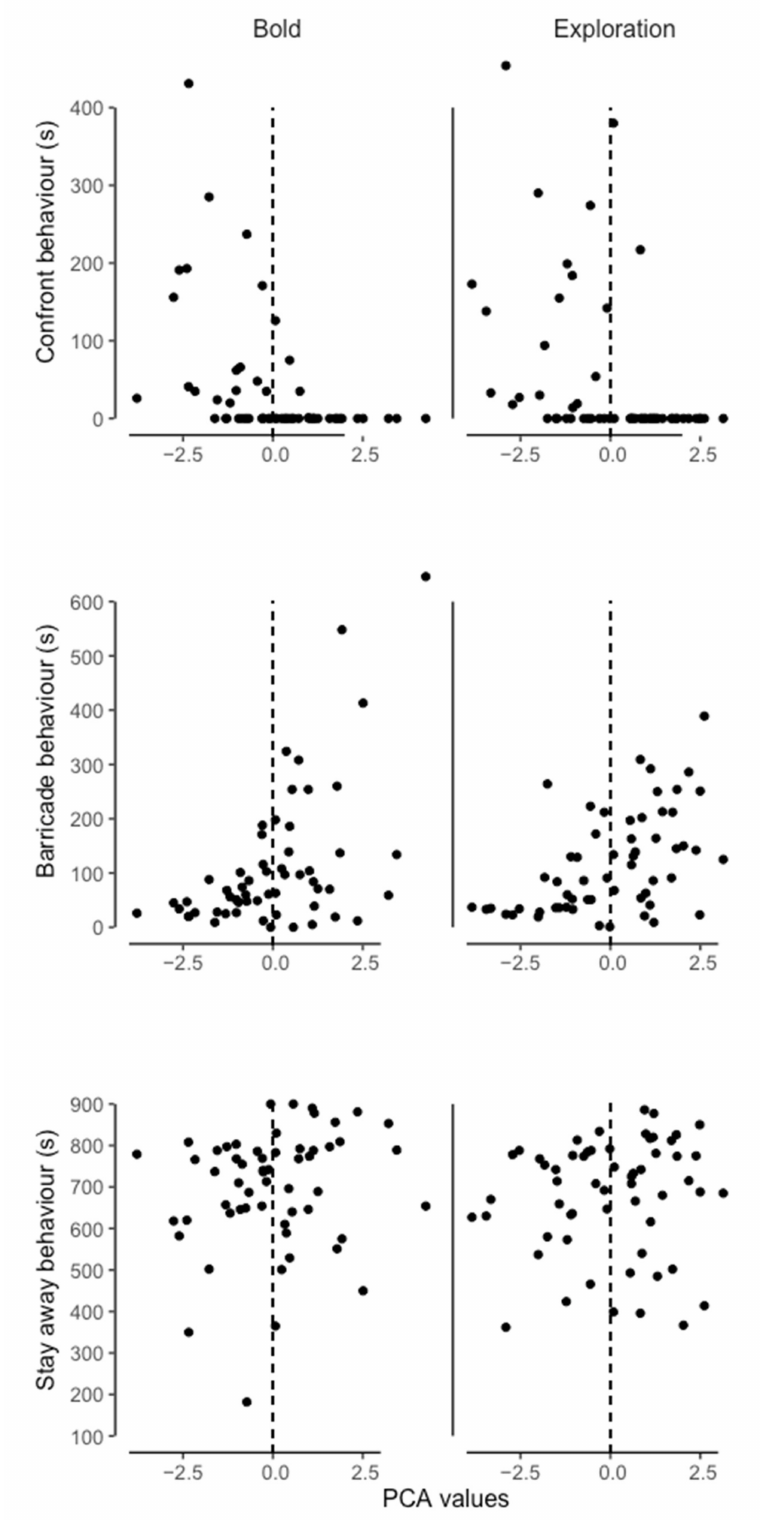
Figure 3. Values for each response to disturbance behaviors for naked mole-rat disperser individuals during boldness and exploration tests. Bold and explorative individuals had negative PCA values, whereas shy and avoidant individuals have positive PCA